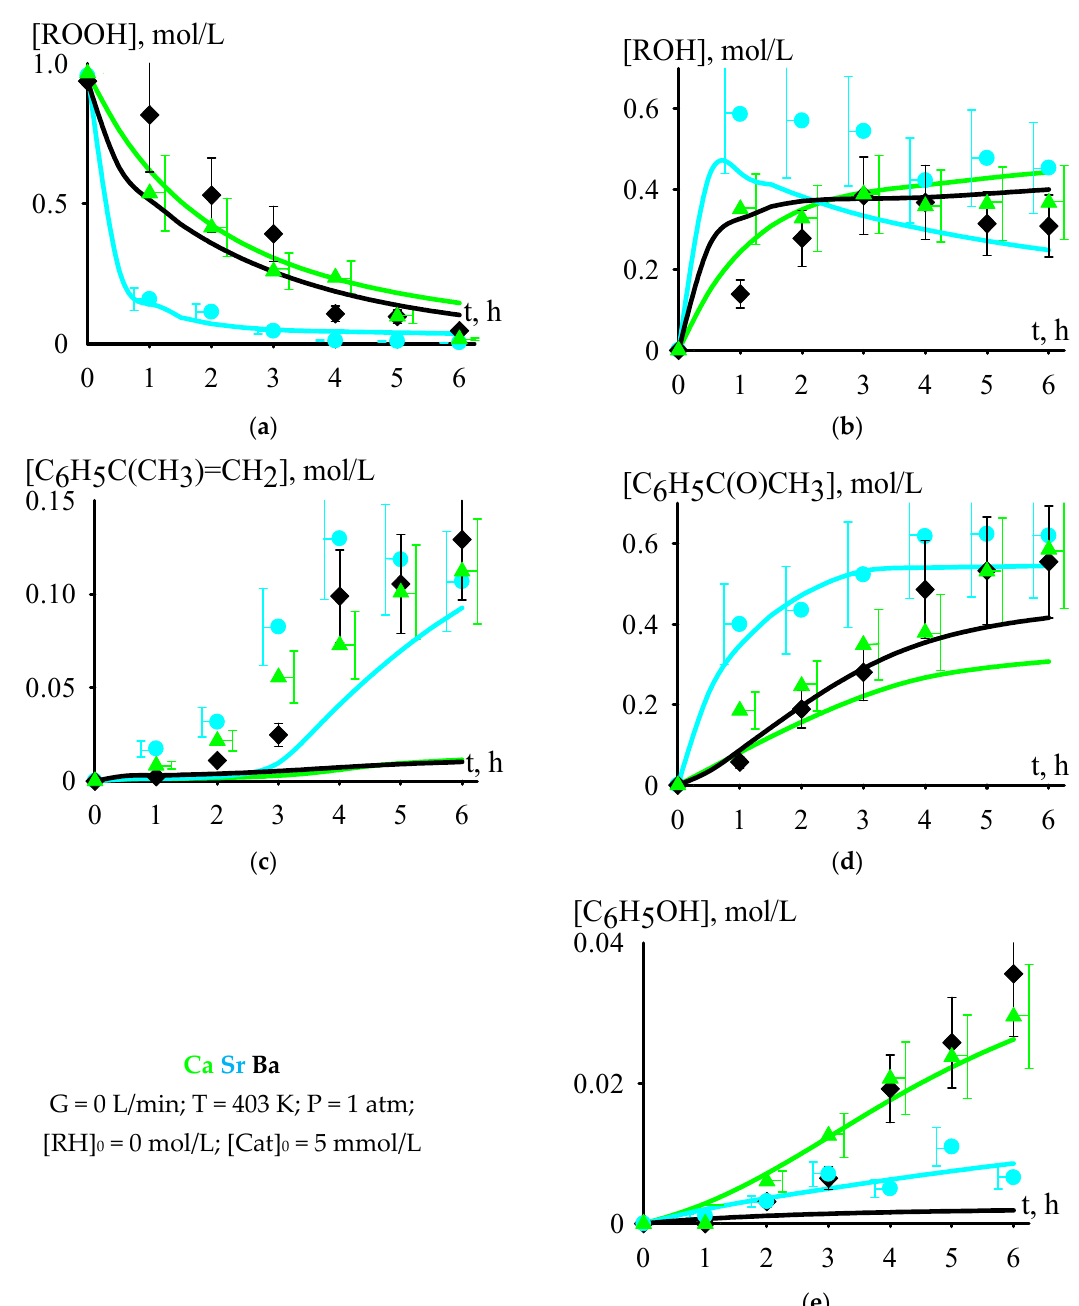
Figure 1. The dependencies of the component concentrations of the reaction mixture in cumene oxidation versus time: dots are the experimental data, and lines are the calculation by the model; ( a ) ROOH; ( b ) ROH; ( c ) C 6 H 5 C(CH 3 ) = CH 2 ; ( d ) C 6 H 5 C(O)CH 3 ; ( e ) C 6 H 5 OH.